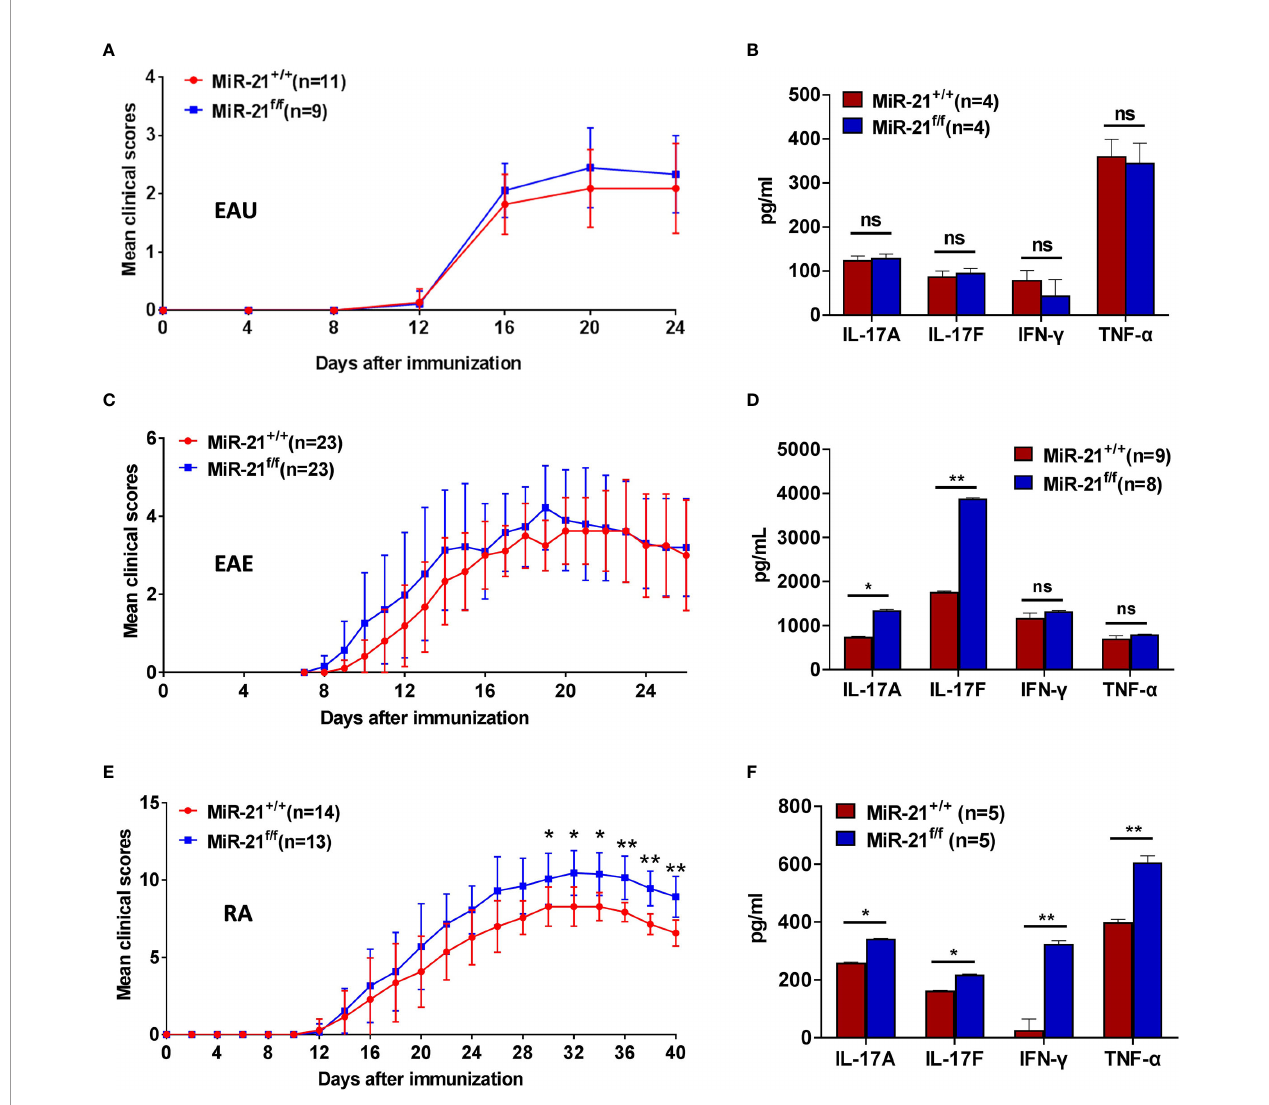
FIGURE 6 | MiR-21 in Tregs is largely dispensable for the development of autoimmune diseases. Mouse models of EAU (A, B) , EAE (C, D) , and RA (E, F) were established in both Foxp3 Cre-YFP miR-21 +/+ (MiR-21 +/+ ) and Foxp3 Cre-YFP miR-21 f/f (MiR-21 f/f ) mice as described in the materials & methods. The mean clinical scores of EAU (A) , EAE (C) , and RA (E) were determined as described in the materials & methods. Results were combined from two independent experiments. Mice were sacri fi ced at the 24th (for EAU), 26th (for EAE) or 40th (for RA) day after immunization. Tissue extracts were prepared from eye (B) , brain (D) and paw (F) and concentrations of IL-17A, IL-17F, IFN- g , and TNF- a in the tissue extracts were determined by ELISA. For (B, D, F) , data are representative of two independent experiments. EAU, experimental autoimmune uveoretinitis; EAE, experimental autoimmune encephalomyelitis; RA, rheumatoid arthritis; ns, no signi fi cance. *p < 0.05, **p <